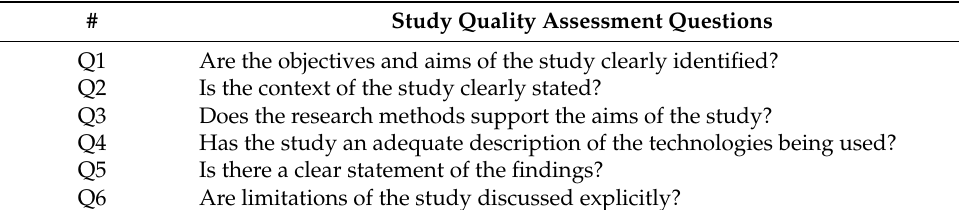
Table 2. Study quality assessment questions.